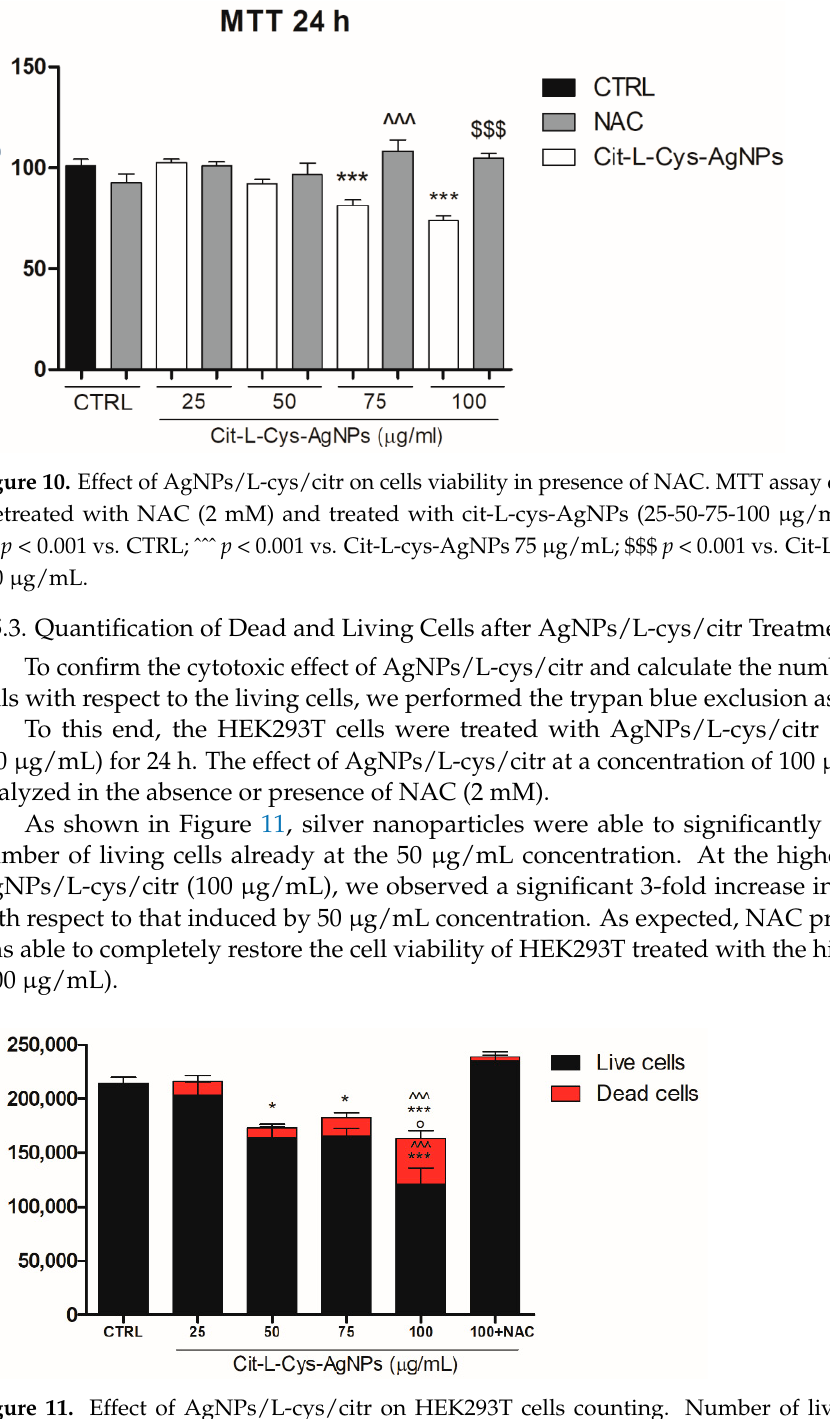
19 of 20 Figure 9. Effect of AgNPs/L-cys/citr on the viability of HEK293T cells. MTT assay was performed on cells treated with cit-L-cys-AgNPs (15-25-50-75-100 μ g/mL). *** p < 0.001 vs. CTRL 3.5.2. Effect of the Antioxidant N-Acetyl-Cysteine on AgNPs/L-cys/citr-Induced Cytotoxicity